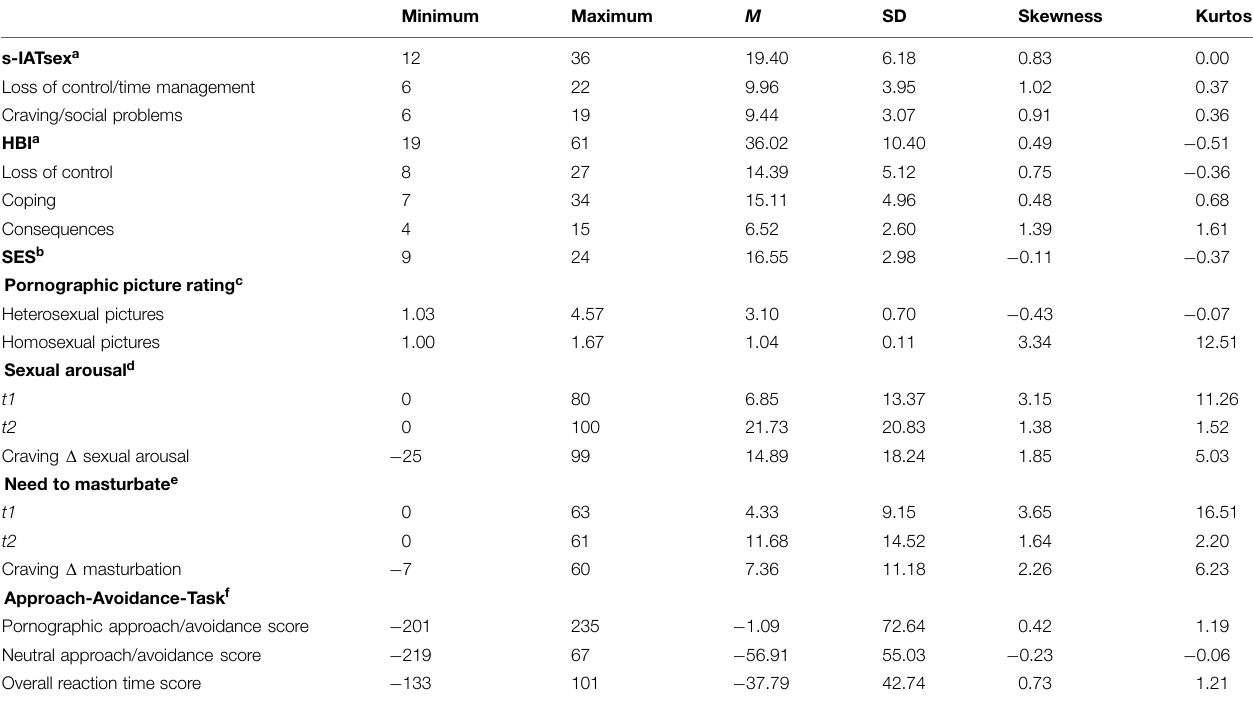
TABLE 2 | Mean values of the s-IATsex, HBI, SES, pornographic picture rating and subjective ratings of sexual arousal as well as need to masturbate and AAT